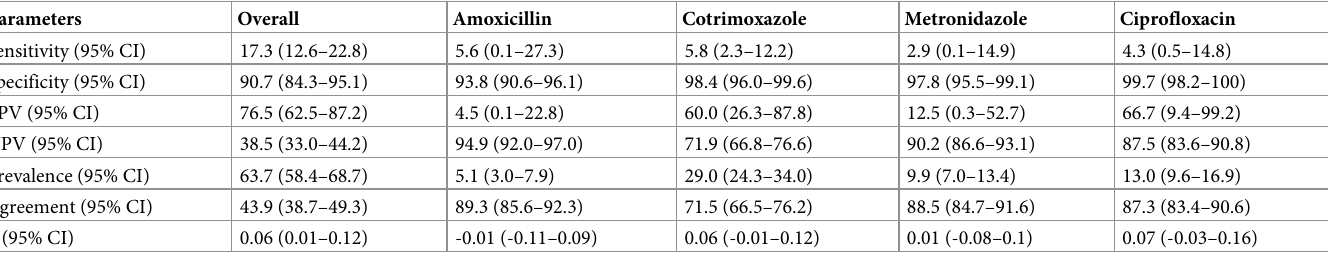
Table 3. Validity of caregivers’ reports of antibacterial intake in children under five years in rural communities of Gulu district, northern Uganda (August, 2019).